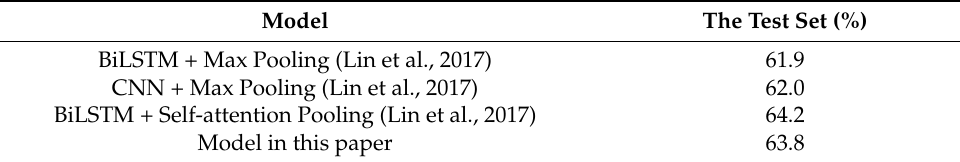
Table 5. The accuracy of each model in emotion classification task on Yelp dataset.